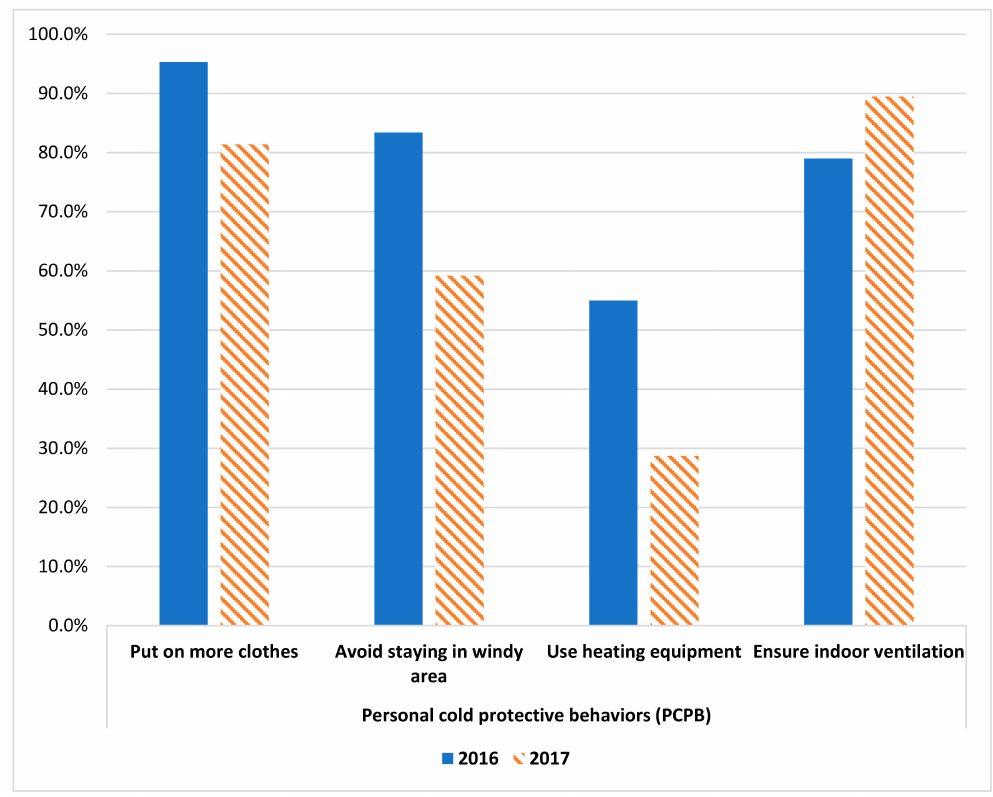
Figure 1. Uptake rate of personal cold protection behaviour among the same group of subjects in 2016 and 2017 cold wave ( n = 429). Remarks: p -values of Chi-square test comparing the four personal cold protective behaviours between 2016 (the colder cold wave) and 2017 (a warmer cold wave) are all <